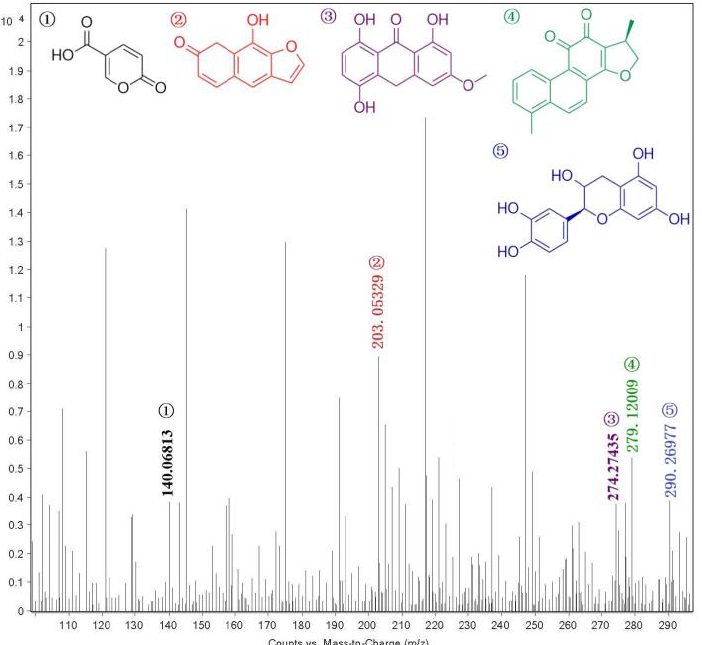
Figure 1. Mass spectrometry analysis of pine needle extracts. ( ① coumaric acid, ② xanthotoxol, ③ bellidifolin, ④ dihydrotanshinone, ⑤ catechin).